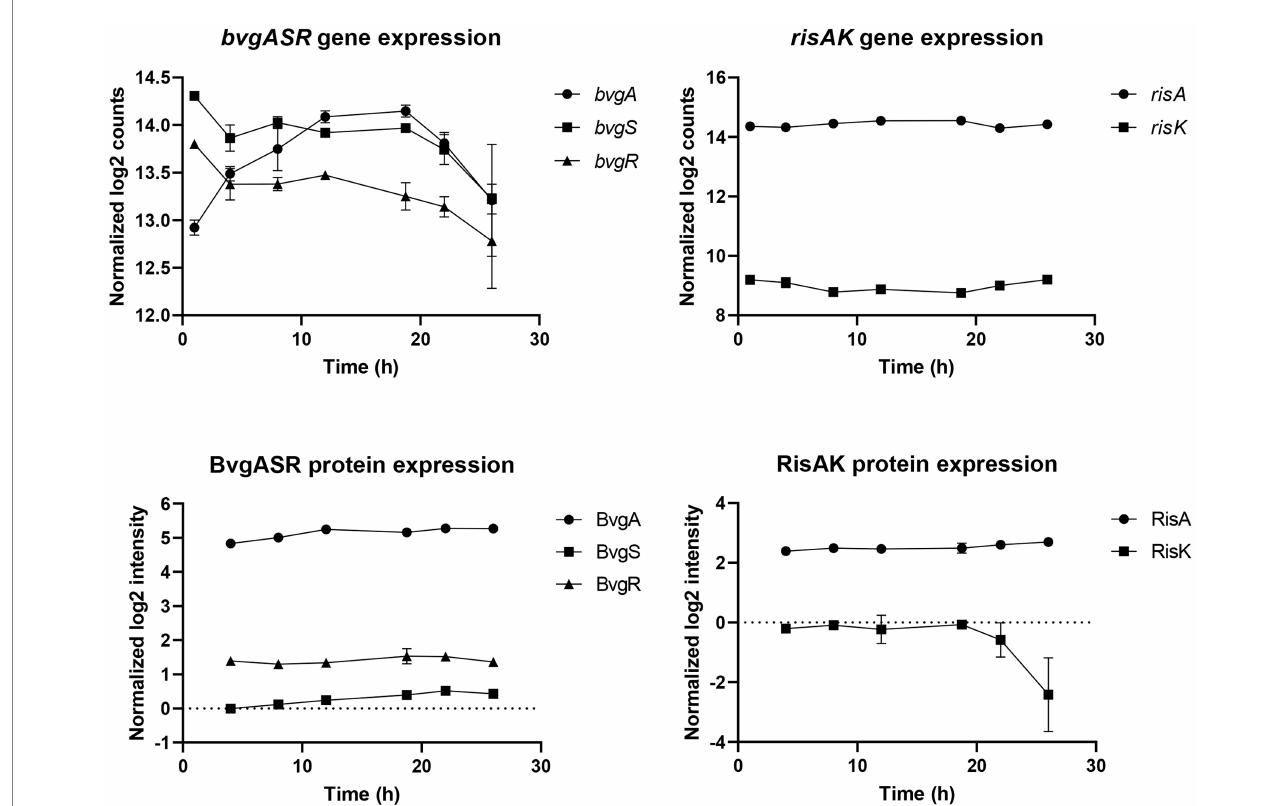
FIGURE 8 Gene and protein expression of BvgASR and RisAK regulation systems during Bordetella pertussis Tohama I culture.